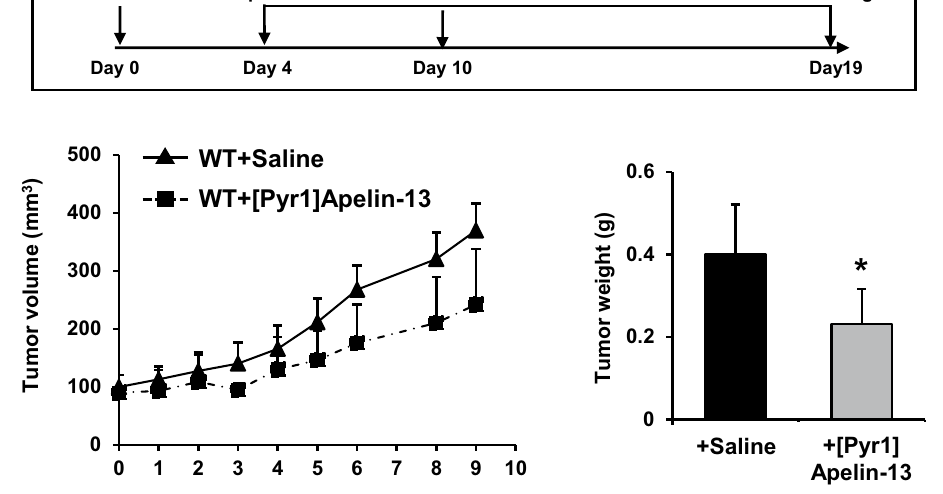
Figure 1. Effects of Apelin on tumor volume and weight. ( A ) Tumor volume curves and tumor weight of MC38 cancer cells subcutaneously (s.c.) inoculated into WT or Apelin-KO mice (n = 7 for each group). ( B ) Tumor growth curves and tumor weight of LLC cells s.c. inoculated into WT or Apelin-KO mice (n = 6 for each group). ( C ) Schedule of tumor models using ALZET osmotic pumps to infuse [Pyr 1 ]Apelin-13 or saline, and MC38 tumor growth curves (n = 5 for each group). MC38 tumor weights on day 19 after inoculation were calculated (n = 5 for each group). All experiments were repeated at least twice. The error bars indicate mean ± SD and all data were analyzed by two-sided Student’s t-test. *p <